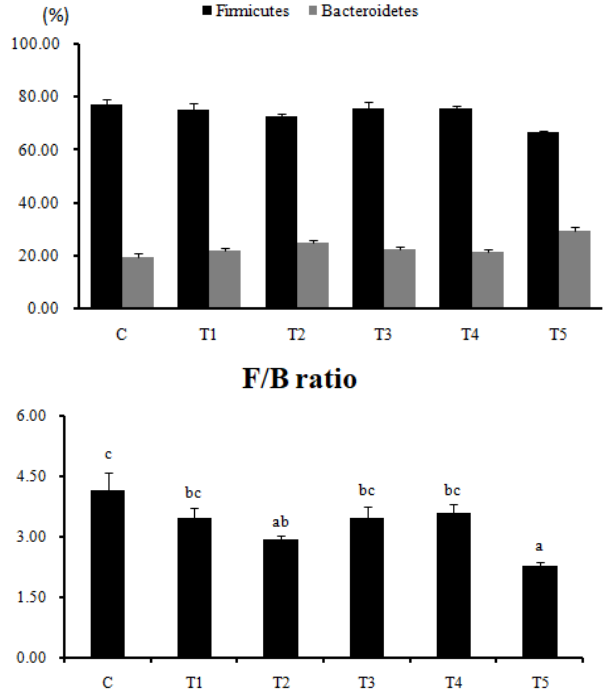
Figure 4. Influence of RC -LAB fermented feed and 3 types of LAB on the relative abundance of phyla Firmicutes and Bacteroidetes in the digestive tract of rats by next generation sequencing (Illumina MiS- eq; Chunlab Inc., Seoul, Korea). RC -LAB, Rubus coreanus -derived lac- tic acid bacteria. Data represent means±standard deviations of 8 replicates. C, control; T1, 1% RC -LAB fermented feed; T2, 2% RC -LAB fermented feed; T3, 2% L. plantarum ; T4, 2% L. acidophilus ; T5, 2% B. animalis . a-c Means are significantly different within the same row